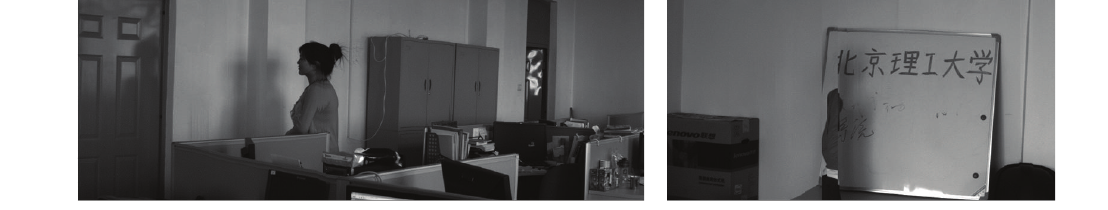
Figure 8: Stitching results of [8].